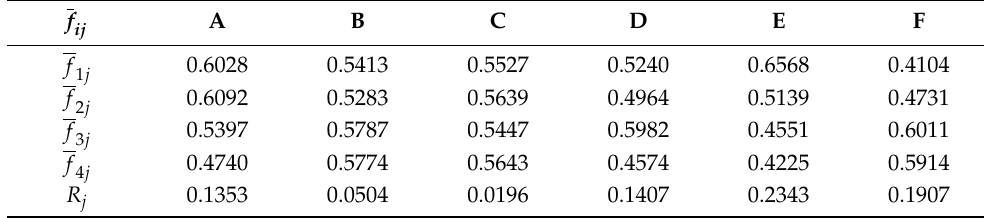
Table 9. Results of the extreme